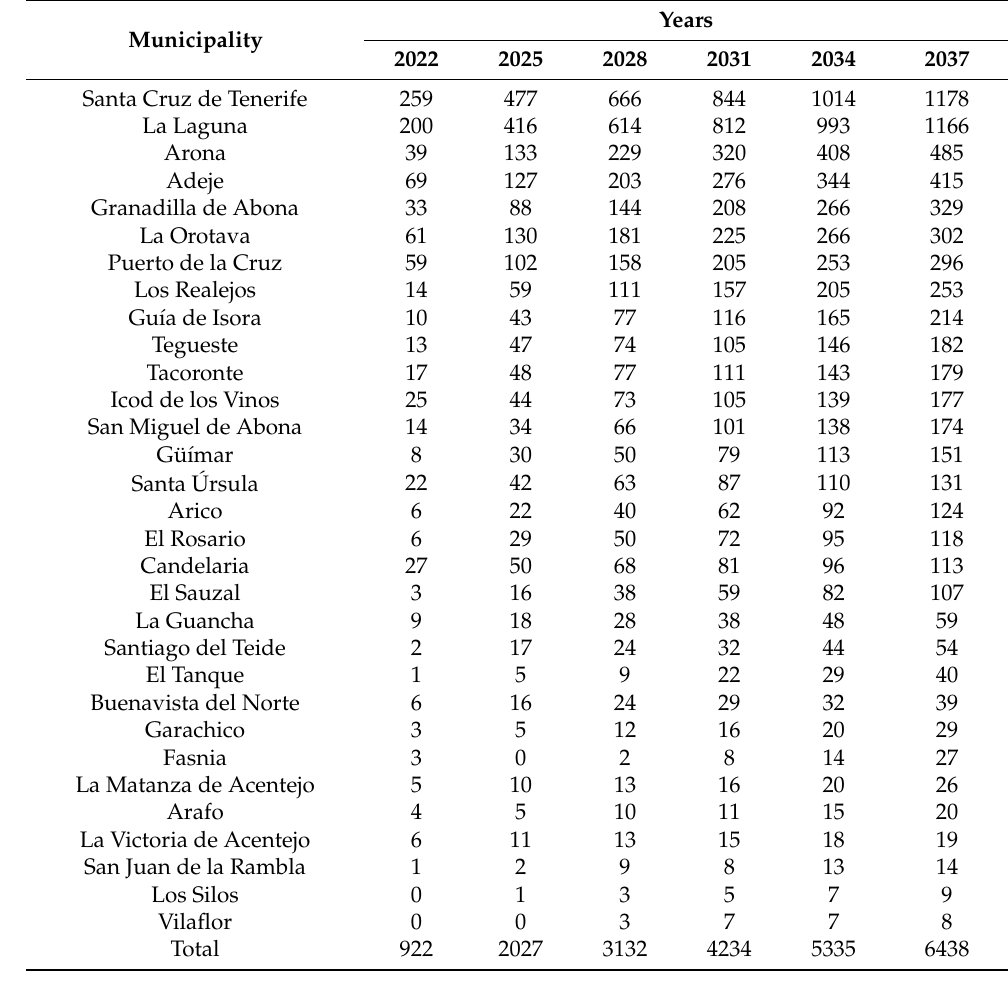
Table 2. Number of EV charging points per municipality.